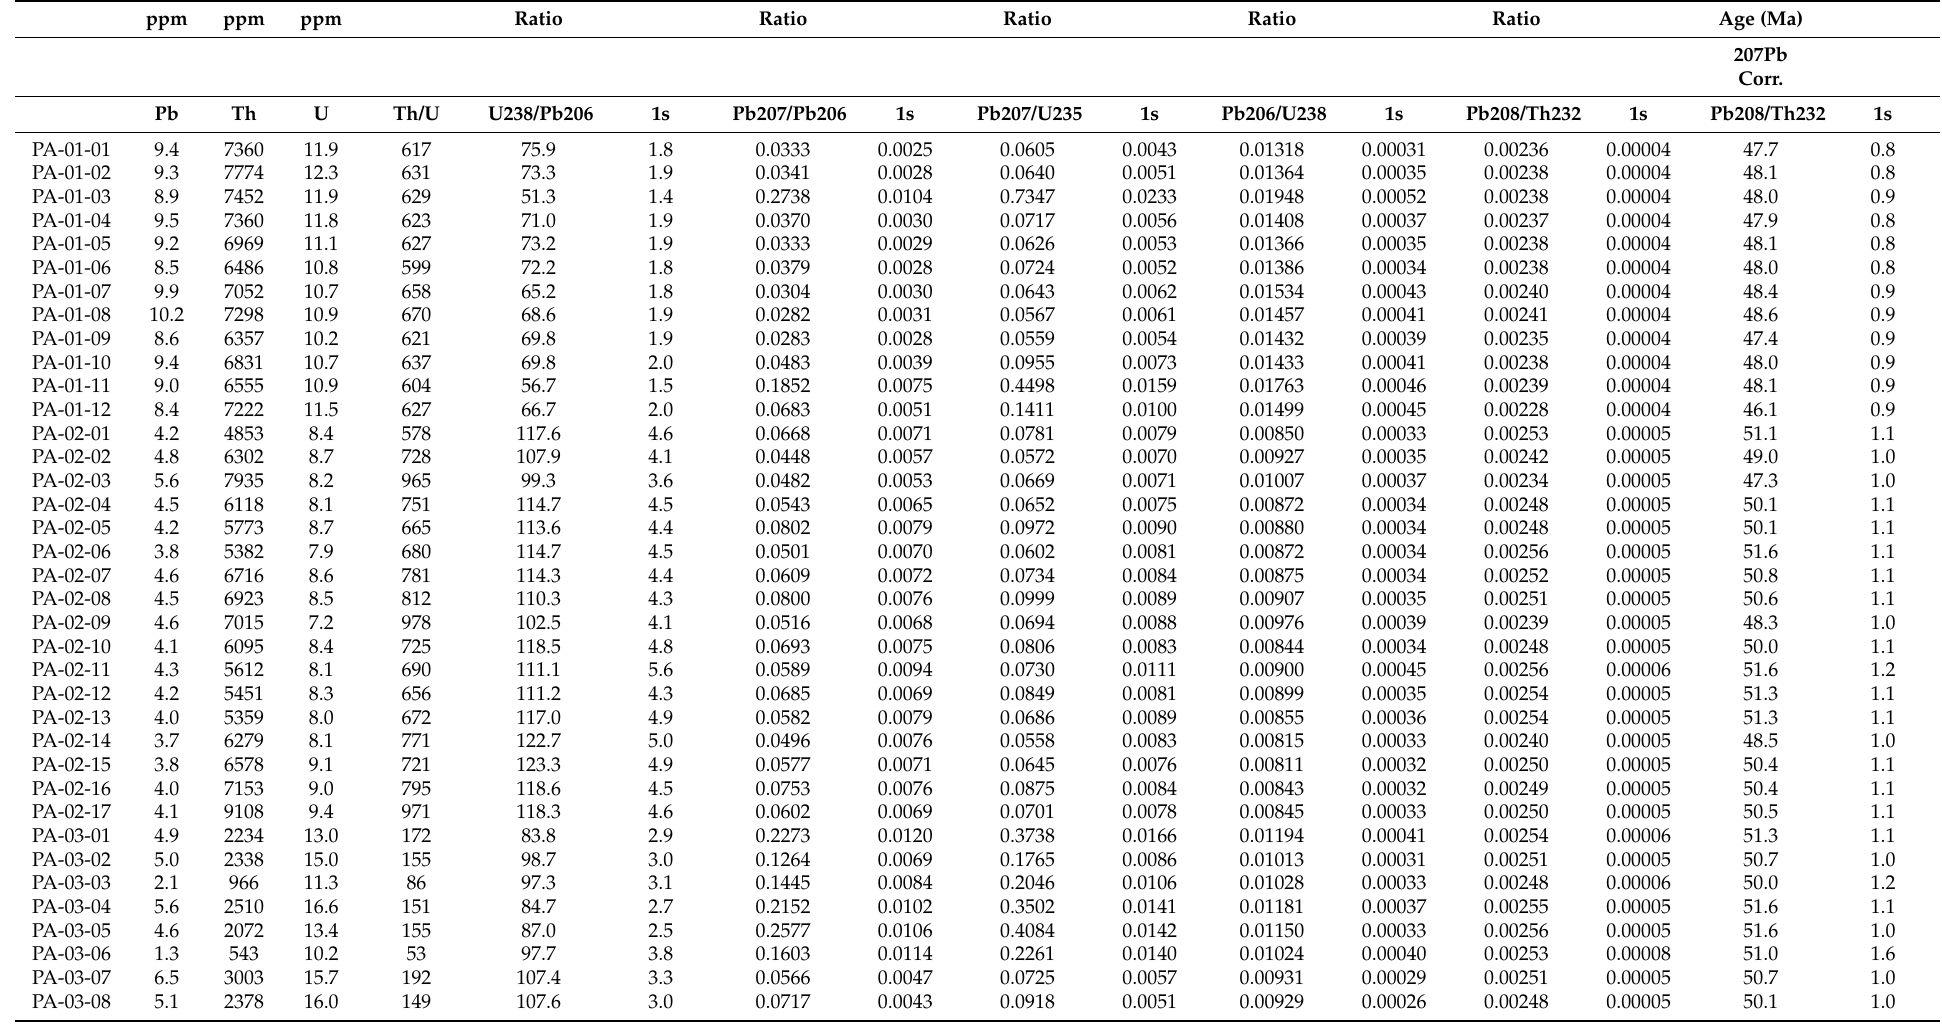
Table 1. U–Th–Pb isotope data of parisite using laser